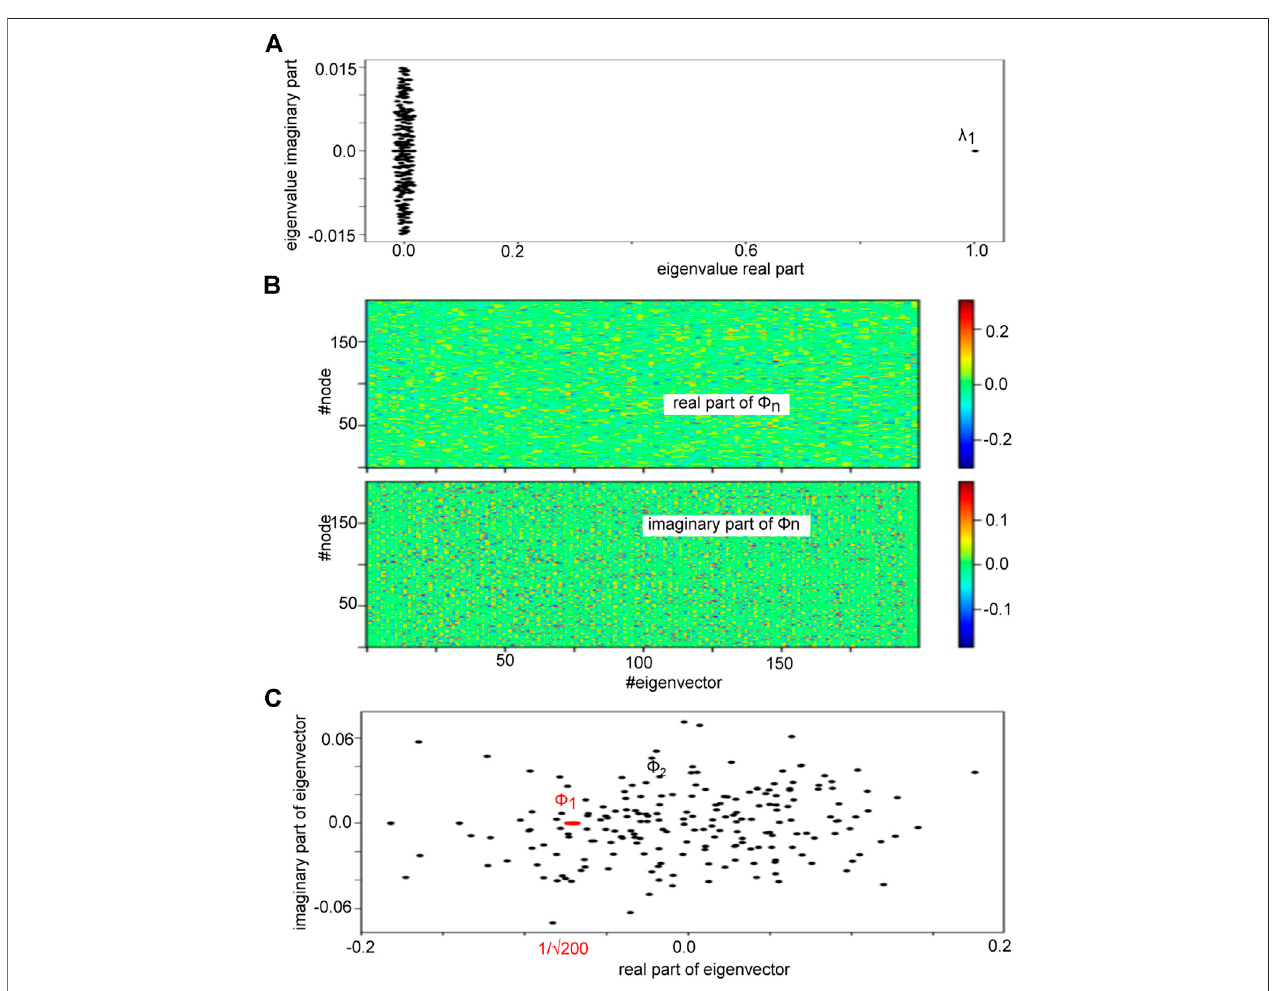
FIGURE 2 | Eigenvalue spectrum of an Erdös-Rényi adjency matrix A under study and its eigenbasis. (A) The plot shows the eigenvalues in the complex plane demonstrating a clear spectral gap between the fi rst eigenvalue λ 1 and the other eigenvalues λ n > 1 . (B) The panels show the real (top) and imaginary (bottom) part of all unit-normalizedeigenvectorsforillustration.Theyappeartoberandomre fl ectingtherandomnetworktopology. (C) Thenormalizedeigenvector Φ 1 ≈ ( 1 , ... , 1 ) / maximum eigenvalue λ 1 ≈ 1 plotted in complex plane together with the eigenvector Φ 2 of the second largest eigenvalue λ 2 (cid:1) 0 . 015 + i 0 . 0006. Each dot corresponds to a complex-numbered vector entry in the complex plane. This result con fi rms the choice Φ 1 ≈ ( 1 , ... , 1 ) in Eq. 9 .